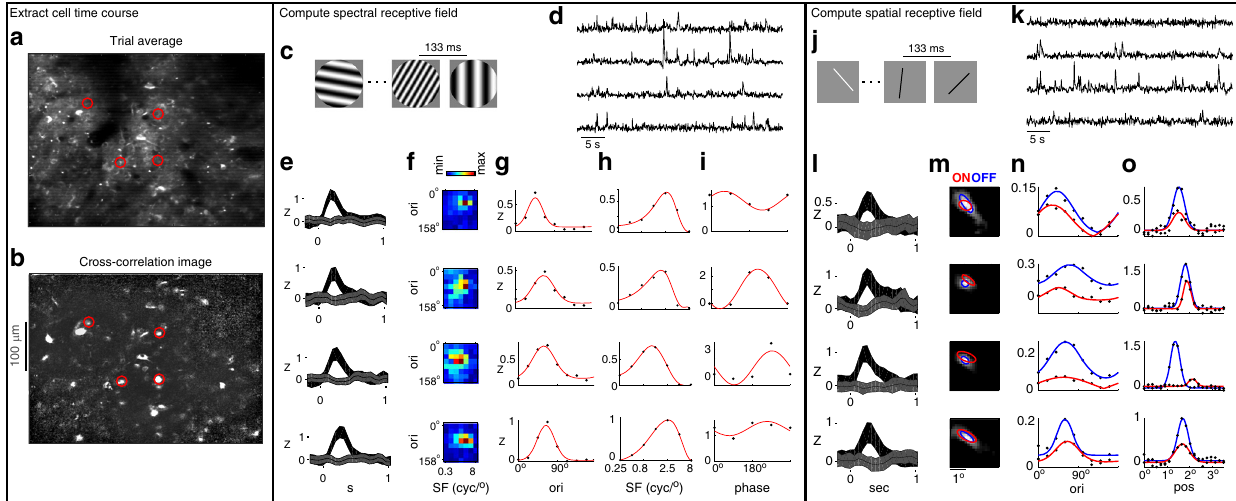
Fig. 2 Measuring spectral and spatial RFs with two-photon calcium imaging of GCaMP6f. a Average image from the fi rst trial (40 s). b The local cross- correlation image was used to identify groups of pixels that have common temporal dynamics. Four examples of manually selected neurons are outlined in red. Their mean responses are shown in panels to the right. c Illustration of the random grating stimulus. d Time courses from one trial of the four example cells in a . e Mean and SE of response following stimulus onset. The two traces in each panel correspond to the orientation/SF combination that elicited the largest (black) and smallest (gray) response. f Color map indicating the normalized response to each orientation and SF in the ensemble. Responses were averaged over spatial phase. The color range spans the minimum (blue) to maximum (red) response of each cell. g Orientation tuning curve (black dots) computed by taking a weighted sum over the SF dimension. Gaussian fi t is in red. h Same as g , but for SF. Fit is a difference-of-Gaussian. i Spatial phase tuning curve for the orientation and SF that elicited the largest mean response. The fi t is a sine wave. j Illustration of the random bar stimulus. k Time courses from one trial of the four example cells in a . l Mean and SE response after onset of the bar that elicits the largest (black) and smallest (gray) response. m Grayscale image is the addition of the ON and OFF spatial RF; i.e. the “ spatial envelope ” . The half-max contour of the ON and OFF 2D Gaussian fi ts are shown in red and blue, respectively. n The ON and OFF orientation tuning curves (black), measured by averaging over the position dimension, with Gaussian fi ts (red and blue). o The ON and OFF line weighting functions (black) taken at each cell ’ s optimal orientation, with Gaussian fi ts (red and blue). This experiment was performed once in three different regions-of-interest, in two